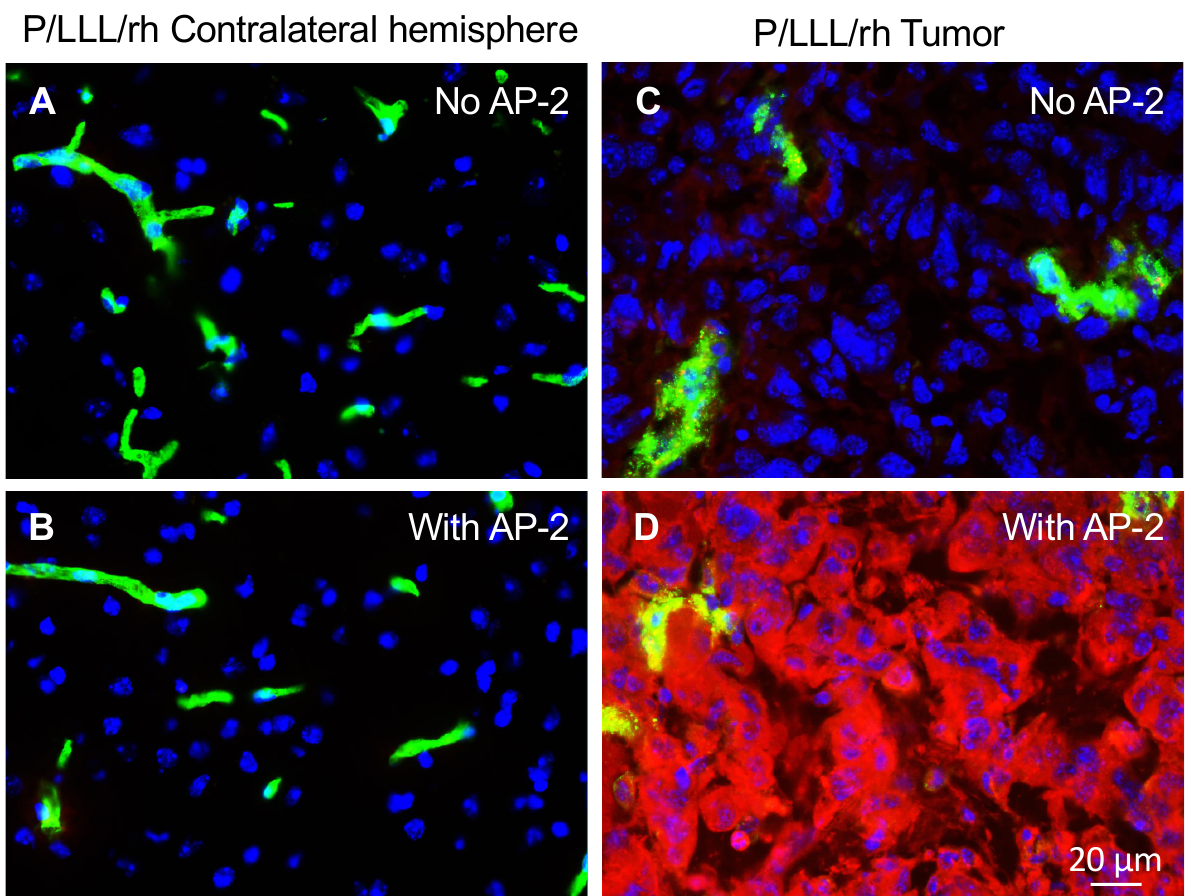
Figure 4. AP-2 enables BBB crossing by MNPs after I.V. injection. ( A ) P/LLL/Rhodamine in unaffected brain. ( B ) P/AP- 2/LLL/Rhodamine in unaffected brain. No red signal is visible. ( C ) P/LLL/Rhodamine in GL261 GBM. Very weak red signal. ( D ) P/AP-2/LLL/Rhodamine in GL261 GBM, showing strong signal in the tumor cells. MNPs with the PMLA backbone, AP-2 peptide, LLL, and rhodamine were IV-injected into mice with intracranial GL261 GBM. Animals were sacrificed 3 h post-drug injection. In addition, 15 min before mice were euthanized, lectin-AF488 (green color) was injected IV to label blood vessels. Frozen sections of mouse brains were imaged in a Leica DM6000 B system (scale bar = 20 µ m). Blue: DAPI (nuclear); green: lectin-AF488 (blood vessels); red: rhodamine (PMLA